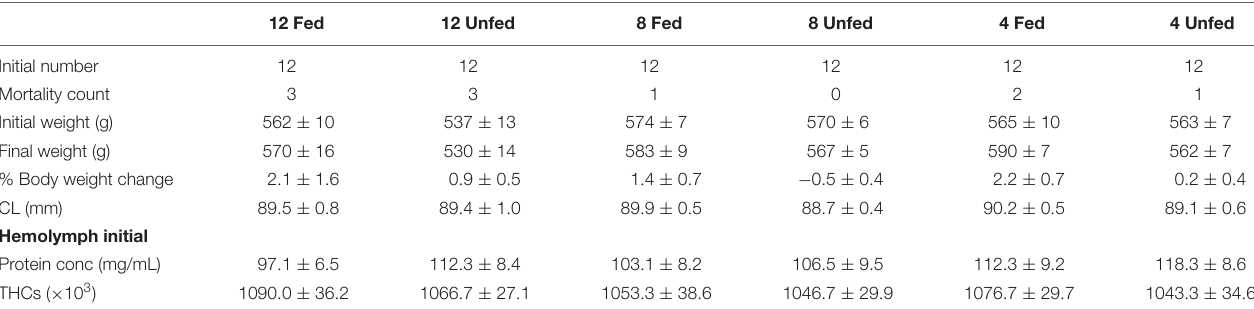
TABLE 1 | Biophysical parameters measured in H. gammarus fed and unfed kept at different holding temperatures (4, 8, and 12 ◦ C). 12